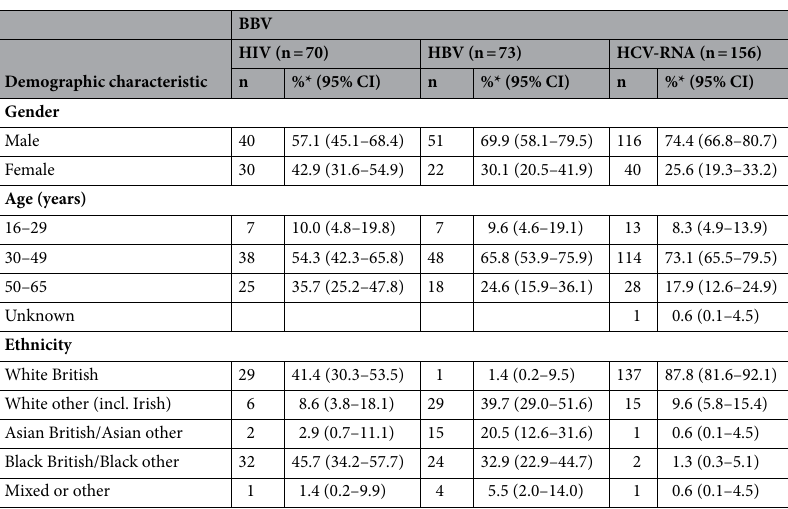
Table 1. Demographic characteristics of patients testing positive for active BBV infection in the ED. *Percentage of individuals within each category calculated using the denominator for each BBV included in the column